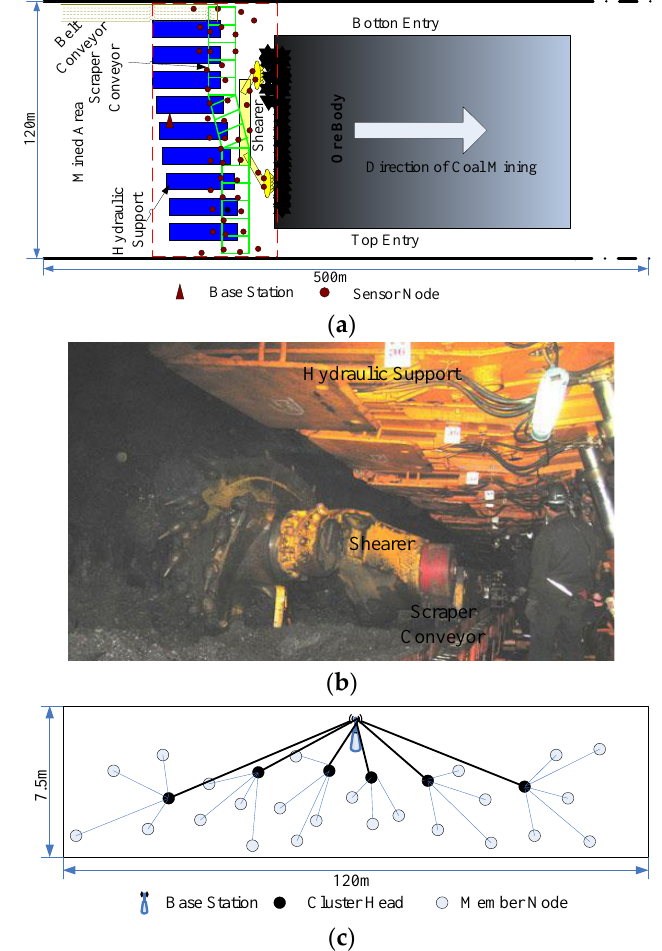
Figure 1. ( a ) Sensor node distribution model on the coal mine face; ( b ) Coal mine face; ( c ) Diagram of the network topology.